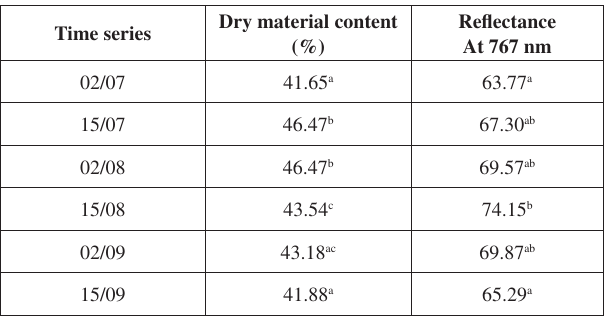
Table 1. Changing of dry material content in the vegetation period based on Tukey variance analysis